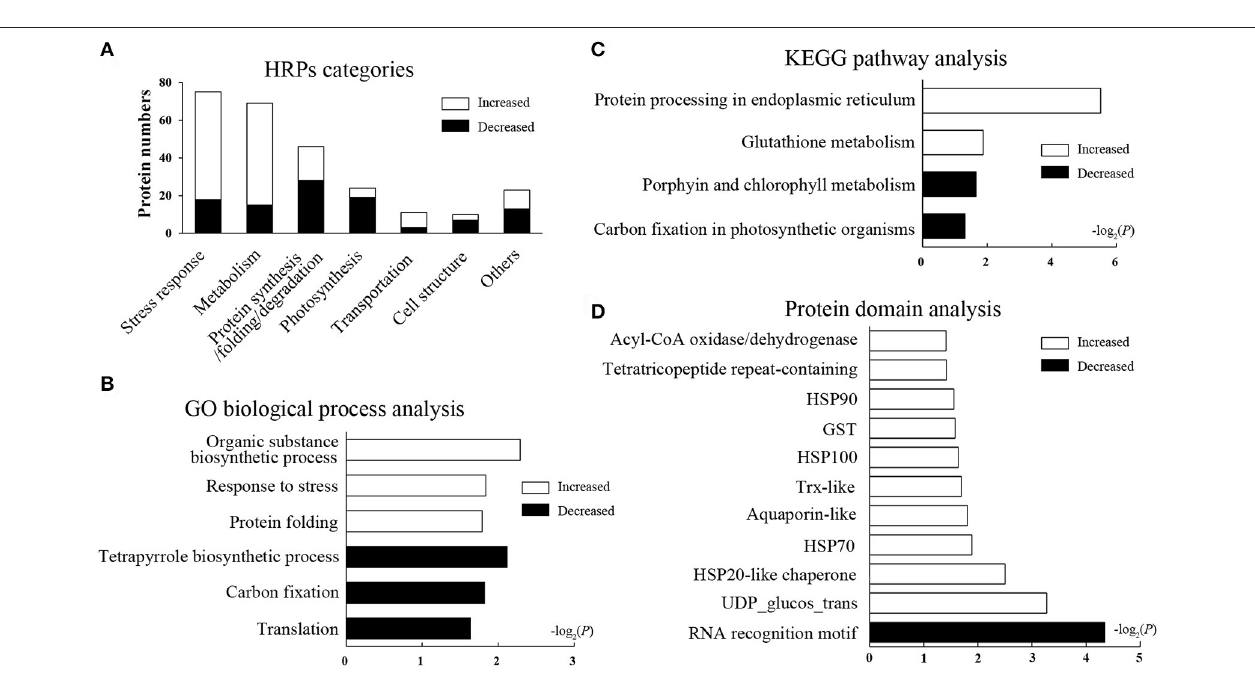
FIGURE 2 | Function categories and enrichment analysis of HRPs. Black bars represent decreased proteins, white bars represent increased proteins. (A) Functional classification of HRPs. (B) GO biological process analysis. The bars represent − log 2 ( P ) where P represents the Fisher’ exact test P -values, and so as it in (C,D) . (C) KEGG pathway analysis. (D) Domain enrichment